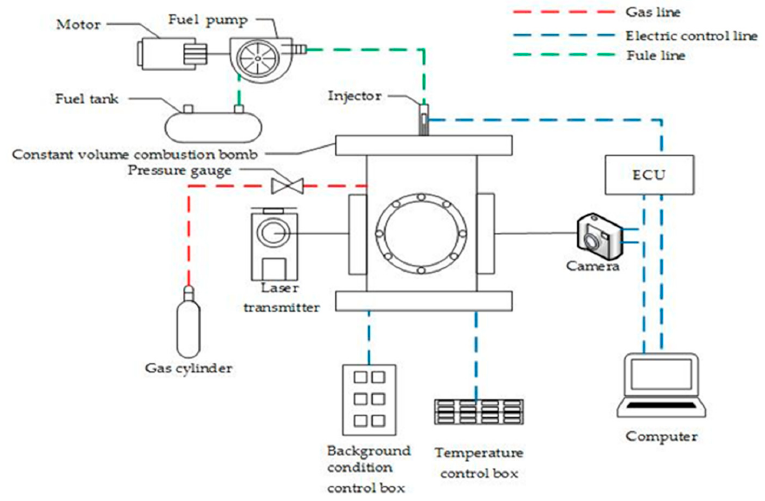
Figure 1. Constant volume combustion bomb visualization experimental system.